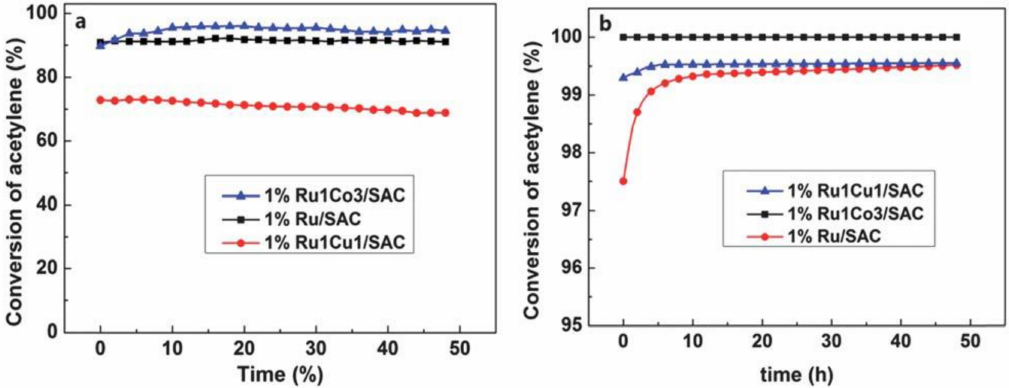
Figure 30. Acetylene conversion ( a ) and VCM selectivity ( b ) over monometallic Ru, Cu, and Co catalysts (reproduced with permission from [330]. Copyright 2013 the Royal Society of Chemistry.).